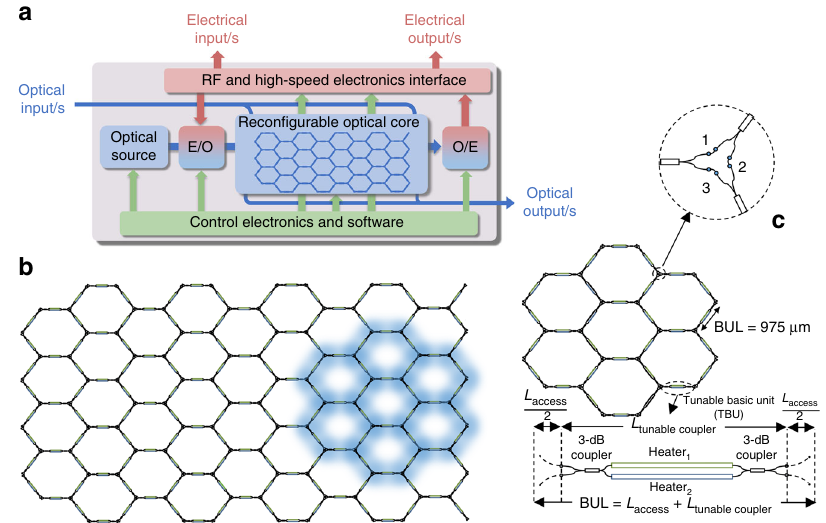
Fig. 1 Software-de fi ned general-purpose photonic processor and its waveguide mesh recon fi gurable core. a Architecture of the processor showing the recon fi gurable core as its central element and the different possible electrical, optical and control input/output signals (E/O: External modulator. O/E: Optical receiver). b Schematic of the hexagonal waveguide mesh; a 7 unit cell structure is marked in blue . c Layout detail of the 7-cell hexagonal waveguide mesh designed and fabricated, including a zoom ( lower ) of a hexagon side of length 1 basic unit length ( BUL ) implemented by means of a 3-dB Mach Zehnder Interferometer ( MZI ) and a zoom ( upper ) of an optical interconnection node. TBU, tuneable basic